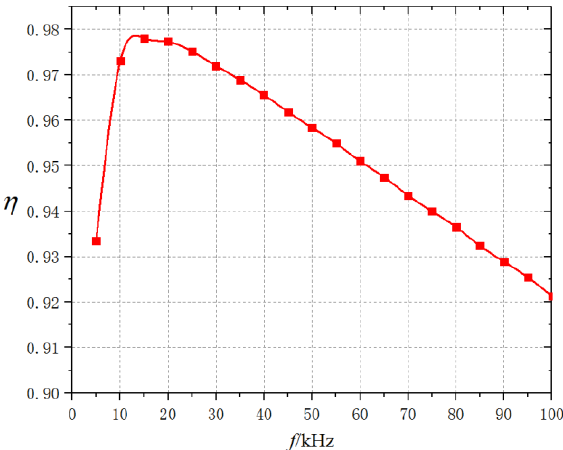
Figure 10. Curve of the efficiency with a different resonant frequency.